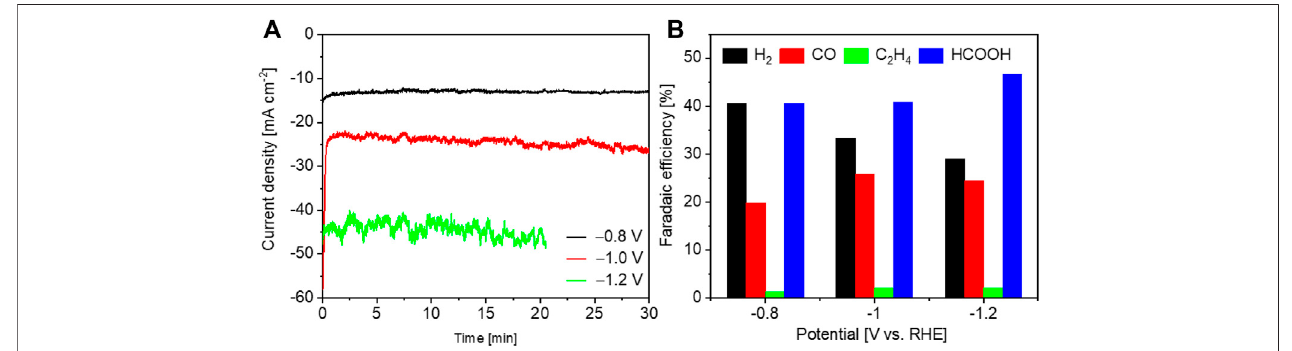
FIGURE5| Comparison oftheselectivityofdifferentelectrodes at various potentials in0.5 M KHCO 3 : (A) Cu 2 O; (B) Cu 2 O-Al-1; (C) Cu 2 O-Al-2; (D) Cu 2 O-Al-3; (E) Cu 2 O-Al-5 and (F) Cu 2 O-Al-9.